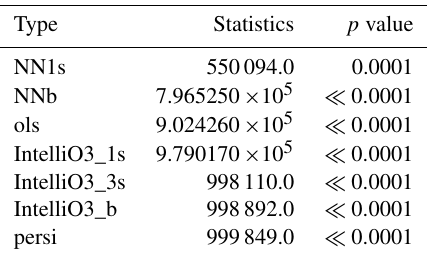
Table B1. Results of two-sided Mann–Whitney u test (5% signifi- cance level) of NN3s and listed competitor